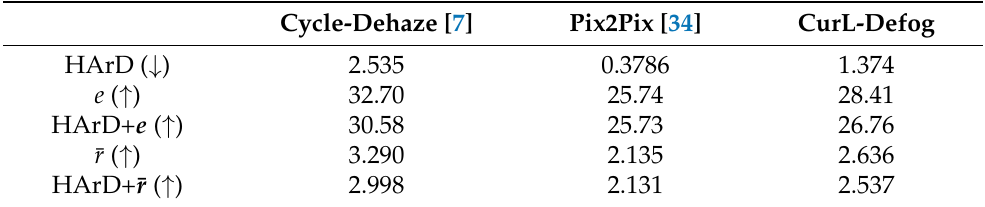
Table 5. Indicators e and ¯ r from [15], the proposed HArD metric and the indicators HArD + e and HArD + ¯ r calculated on the LIVE test set. ↑ indicates that a higher value is better, ↓ indicates that a lower value is better.